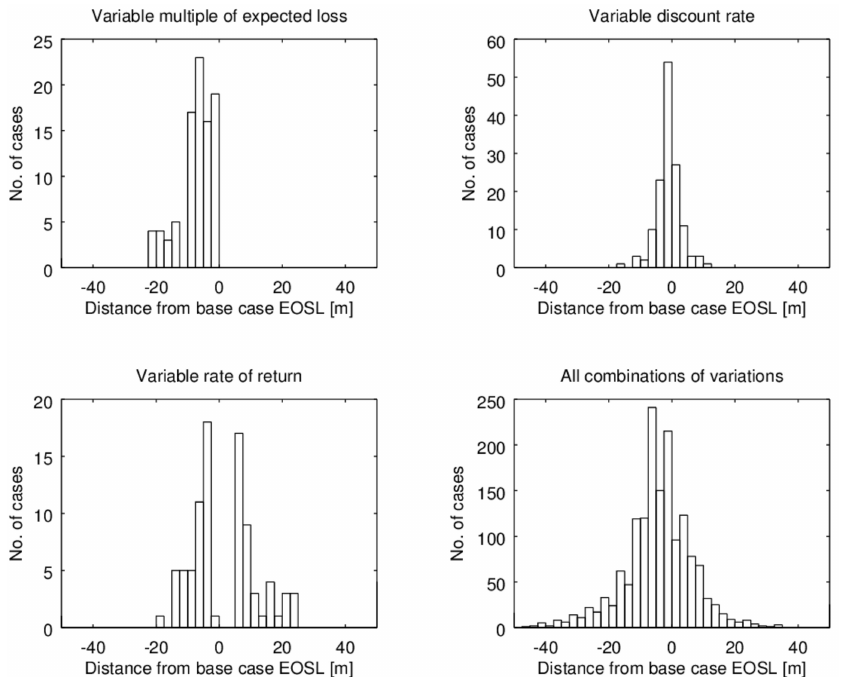
Figure 25. The distance between the EOSL based on the base case parameter values and the EOSL based on different economic constants. Results for profiles in Batticaloa, assuming they all lie in lower-value zones. A negative distance implies a position seaward of the base case